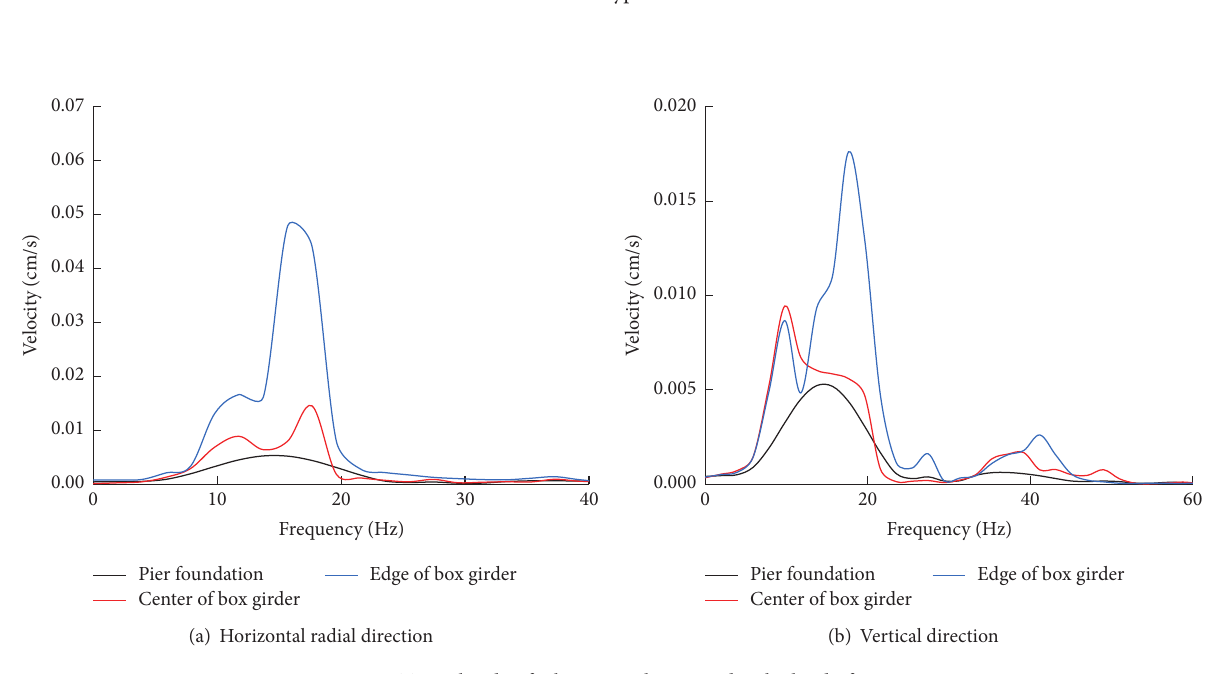
Figure 13: FFT amplitude of vibration velocity under the load of 0.03